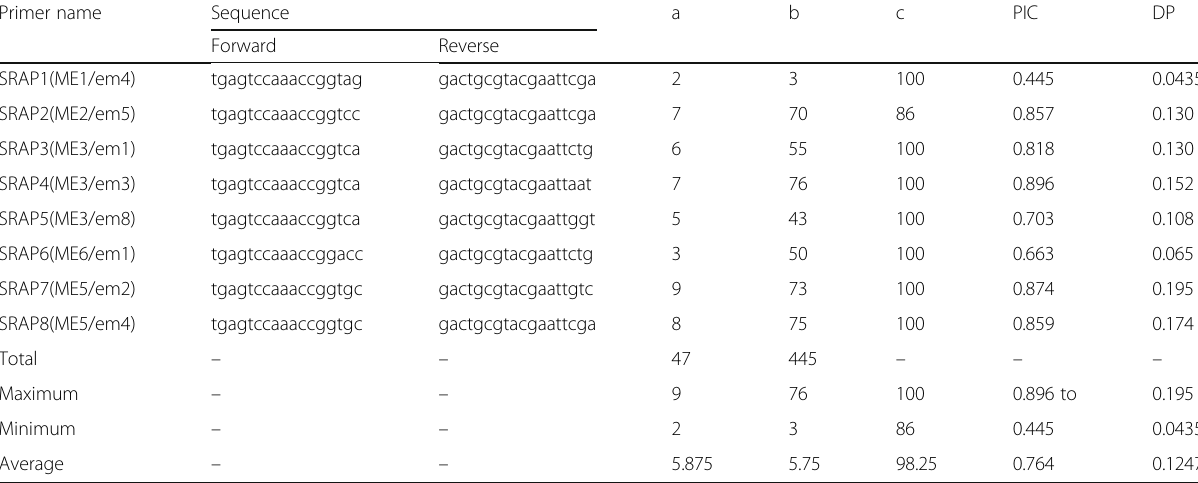
Table 5 Summary of the molecular data of the SRAP marker combinations used for the analysis of 18 faba bean genotypes